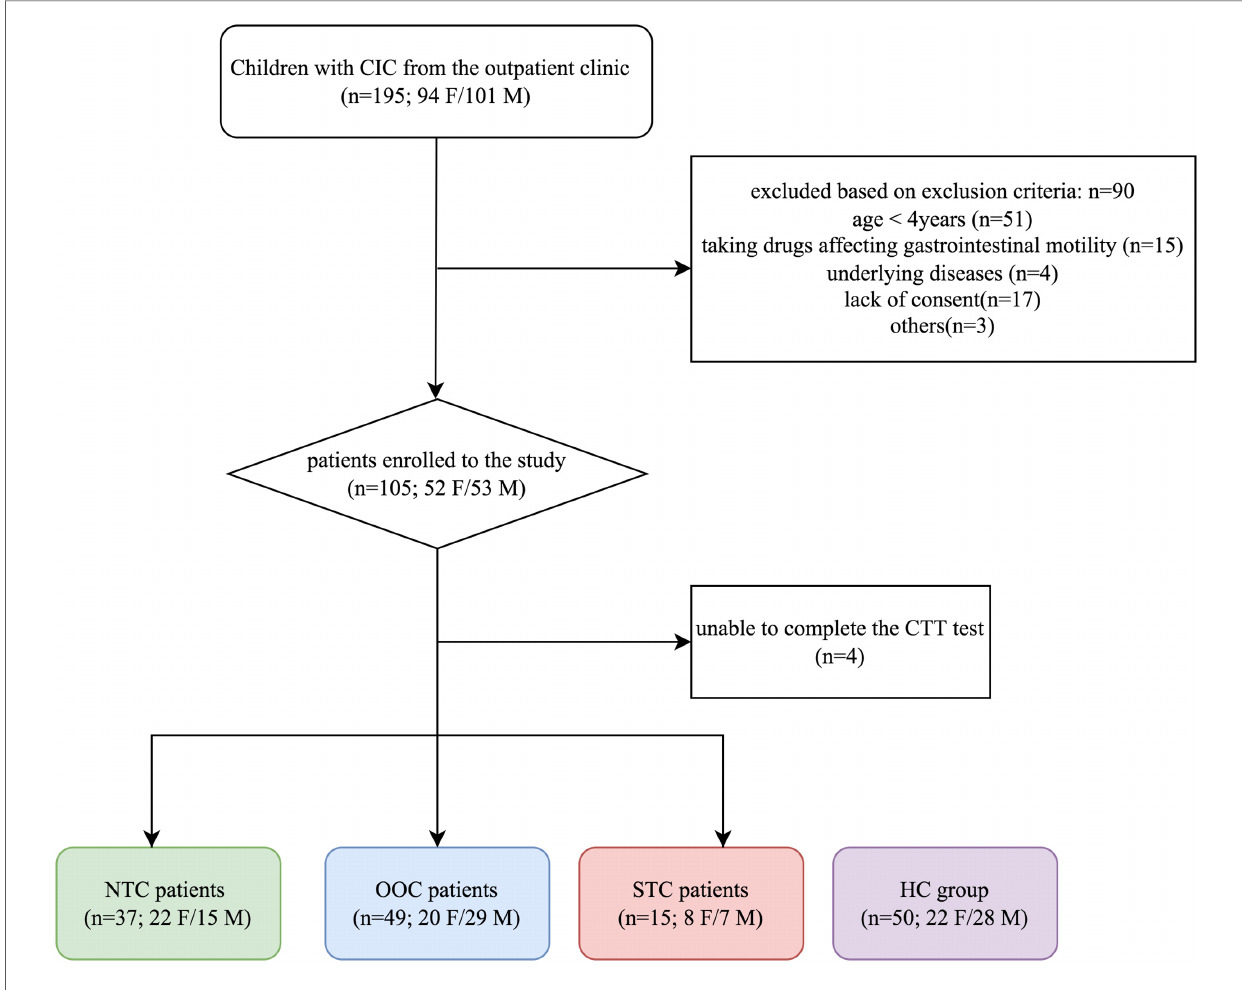
FIGURE 1 Flow chart of participants throughout the study. IFC, chronic intractable constipation; NTC, normal transit constipation; OOC, outlet obstruction constipation; STC, slow transit constipation; HC, healthy controls; F, female; M,